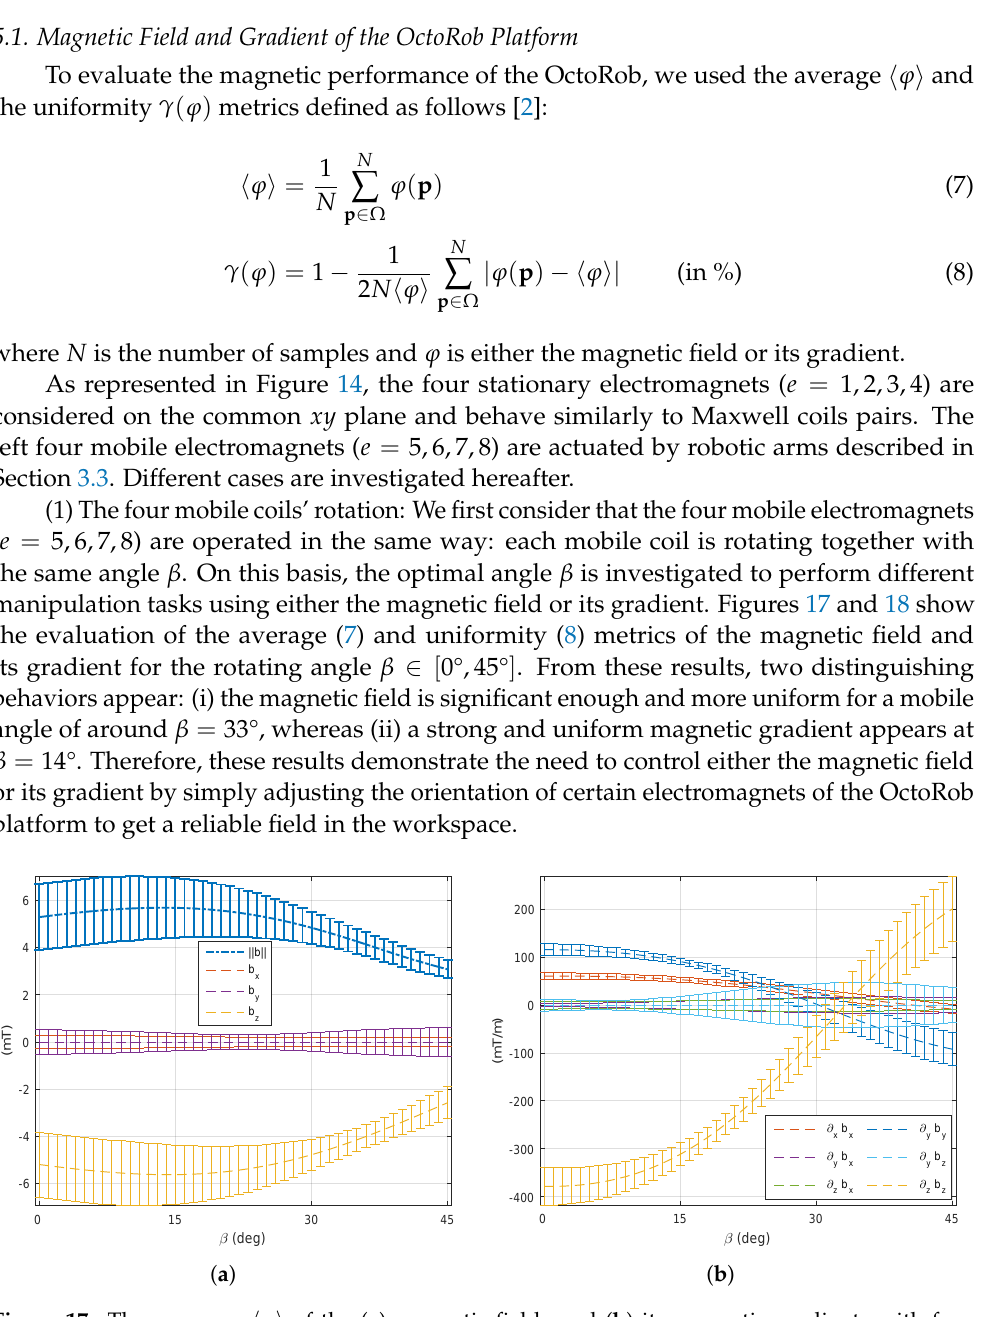
Figure 17. The averages (cid:104) ϕ (cid:105) of the ( a ) magnetic fields and ( b ) its magnetic gradients with four moving electromagnets rotating with angle β ∈ [ 0°,45° ] . The error bar shows the standard deviation of the